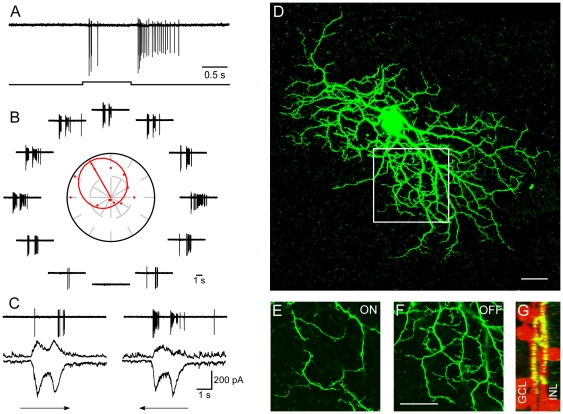
Normal DS in the retina treated by TTX plus Epb.A: ON and OFF responses were elicited by a flashing spot. B: Responses to a rectangle moving in 12 directions. Clear direction selectivity could be observed. C: Asymmetric input evoked by motion from null and preferred directions. Membrane potential was held at −65 mV and 0 mV, respectively. D: Dendritic morphology of the recorded cell. E–G: The region indicated by the white square in D. The dendrites in the ON and OFF sublaminae are shown in E and F. G: The side view showing costratification of DSGC dendrites and cholinergic bands. Scale bar: 30 µm.